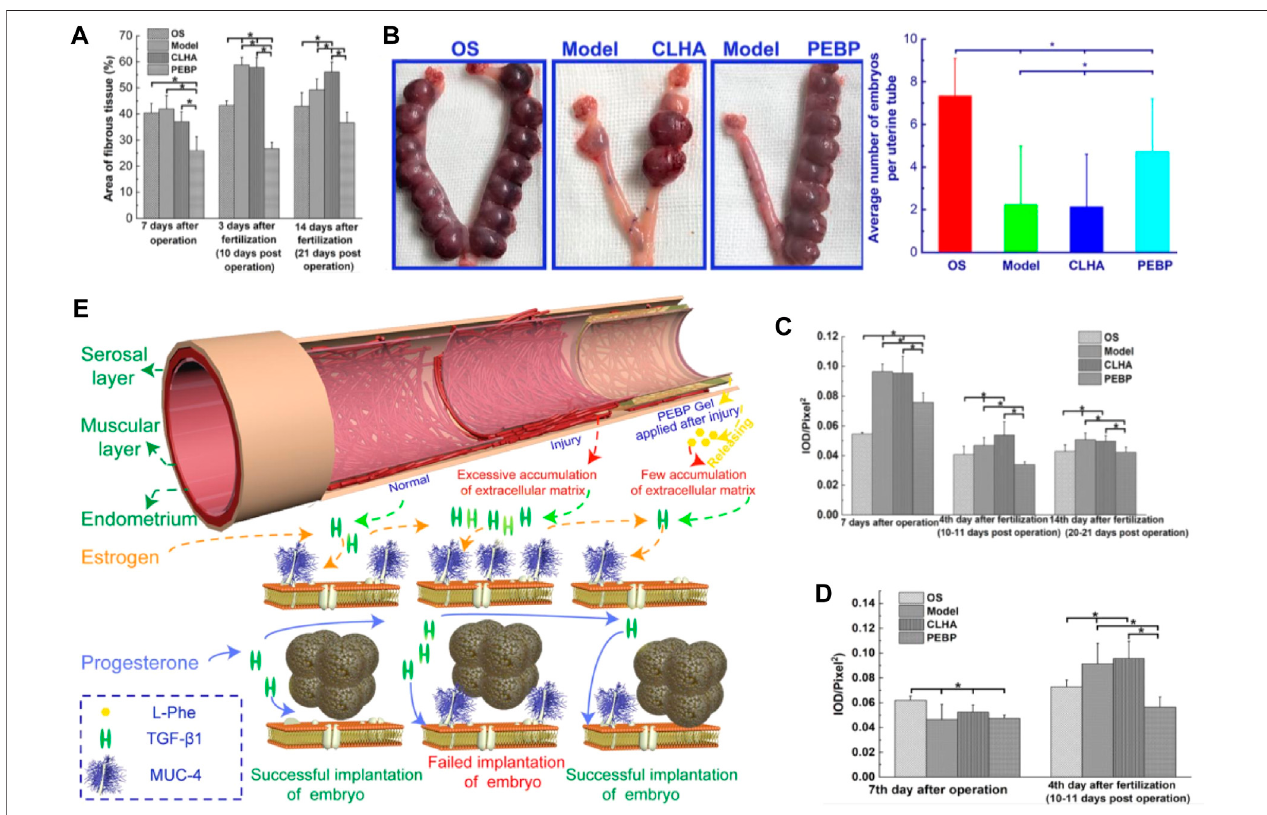
FIGURE 7 | (A) average area ratio of fi brotic tissue with different treatments in the uterine stromal layer; and (B) average number of embryos implanted in uteri with different treatments on day 14 of pregnancy. (C) average IOD of immunohistochemical images of TGF- β 1 expressed at the uterine stromal layer. (D) average IOD of immunohistochemical images of Muc-4expressed at the surface of the uterine wall. (E) Mechanism of PEBP/PEG hydrogel on embryo implantation after uterine curettage,byregulatinginteractionsbetweenTGF- β 1andMuc-4expression.Reproducedwithpermissionfromref(Wangetal.,2020a).Copyright2020American Chemical